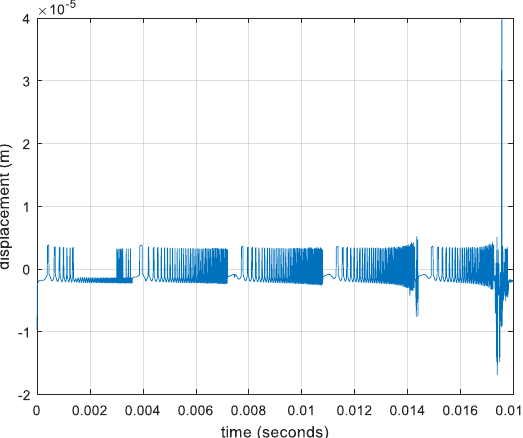
Figure 16. Vibration in time domain (machine with demagnetization fault).